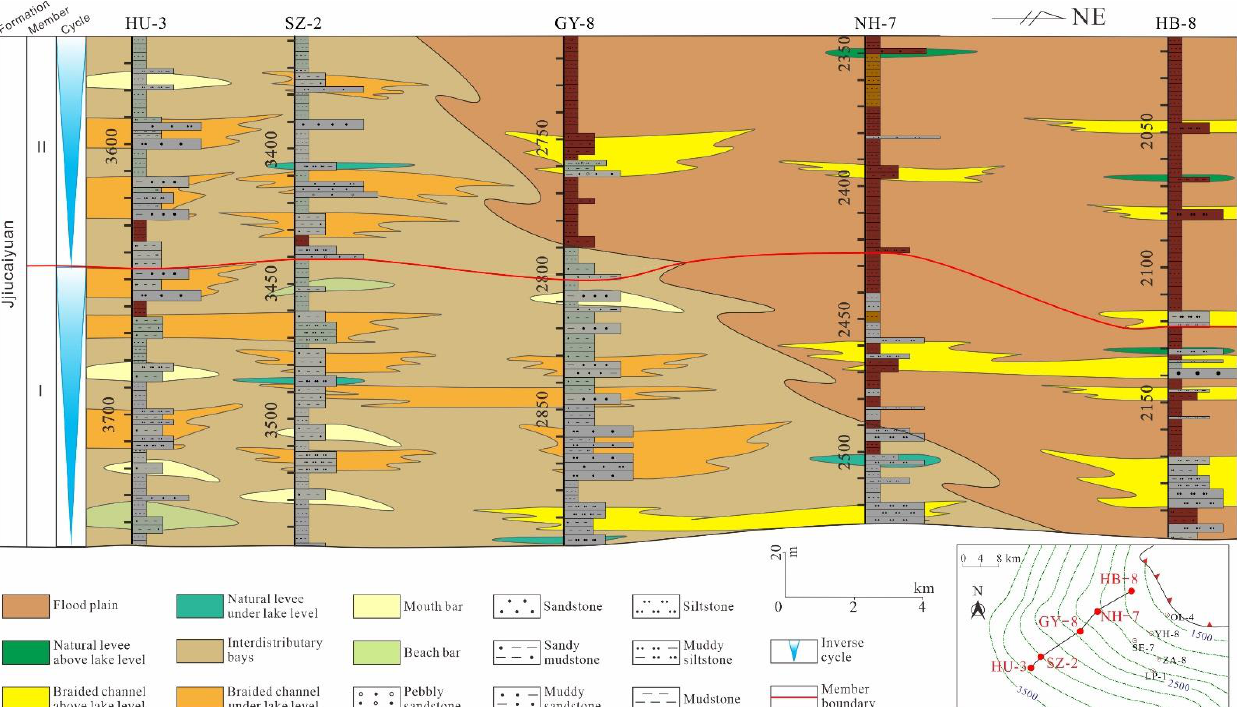
Figure 9. Schematic sedimentary cross-sections of the Jiucaiyuan Formation showing the facies distributions. The lower right corner shows the plan diagram of the connecting drillcores (after He et al. [28]).